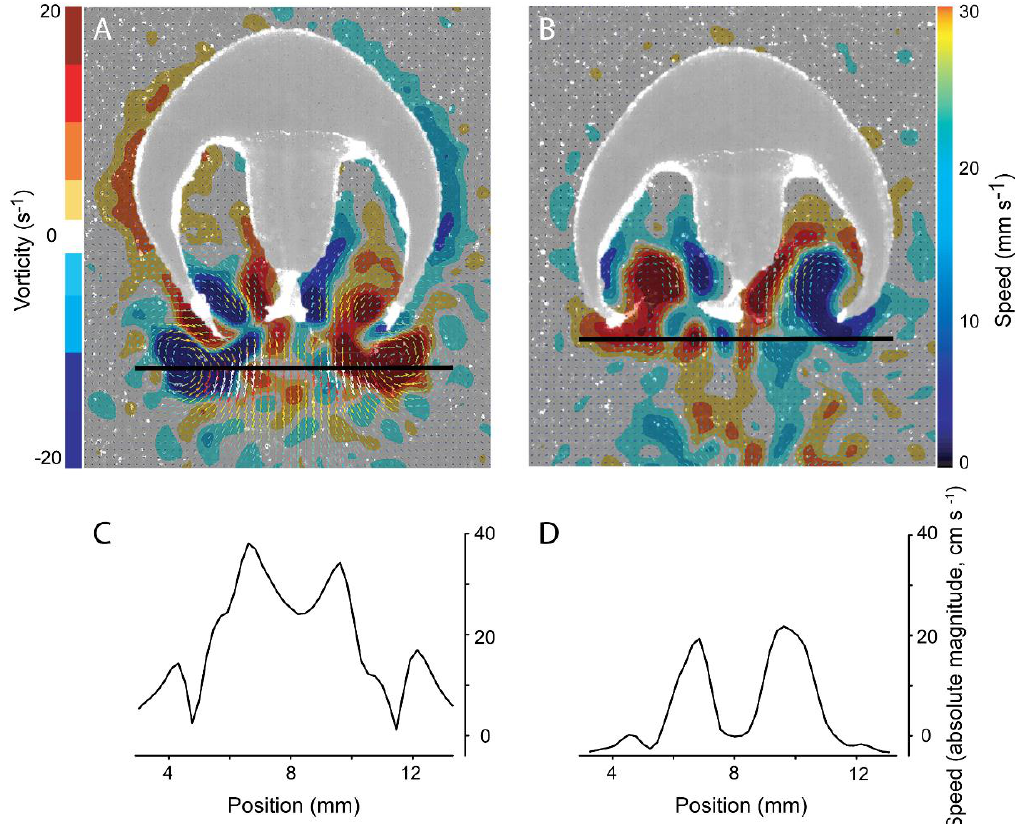
Figure 4. Vortex interface acceleration (VIA) during bell contraction and relaxation of Eutonina indicans . Top images were taken during ( A ) bell contraction and ( B ) bell relaxation of the second pulsation cycle in Figure 2. White vector arrows represent vector magnitudes above the scale limit. Lower panel images ( C , D ) indicate absolute values of vector speeds along transects corresponding to black transect lines (A,B). Note that flows are primarily outward from the bell during contraction and into the bell subumbrellar cavity during relaxation. Peak vector magnitudes occur at interfaces of fluid parcels having opposite sense circulation for both bell contraction and relaxation.